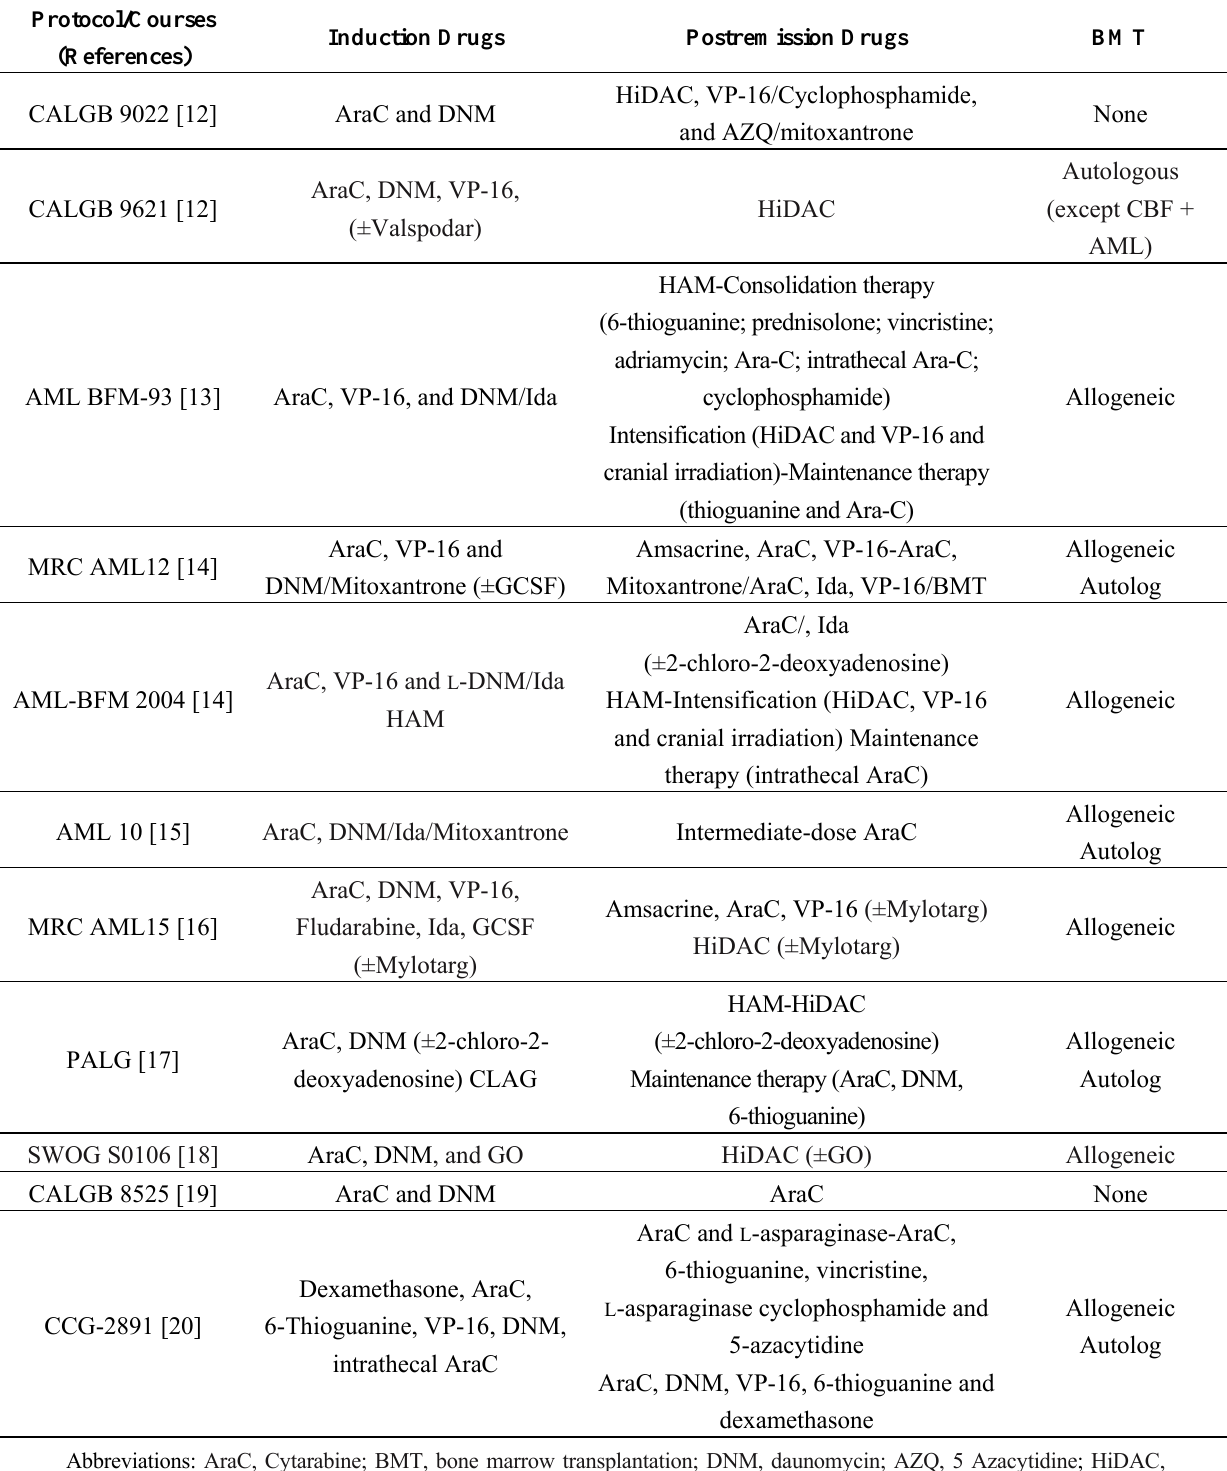
Table 1. Summary of the